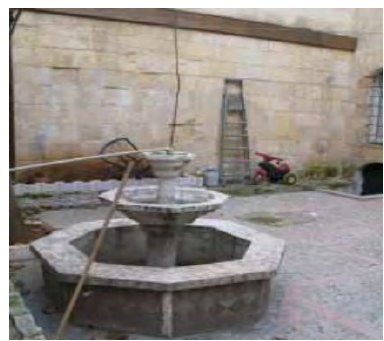
Figure 12. Pool In The Courtyard Of The House (Tas¸tan, 2014)